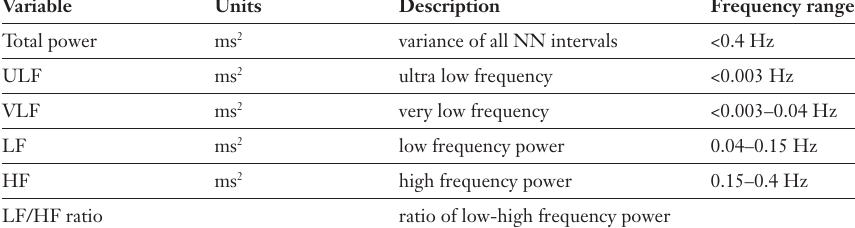
Frequency domain